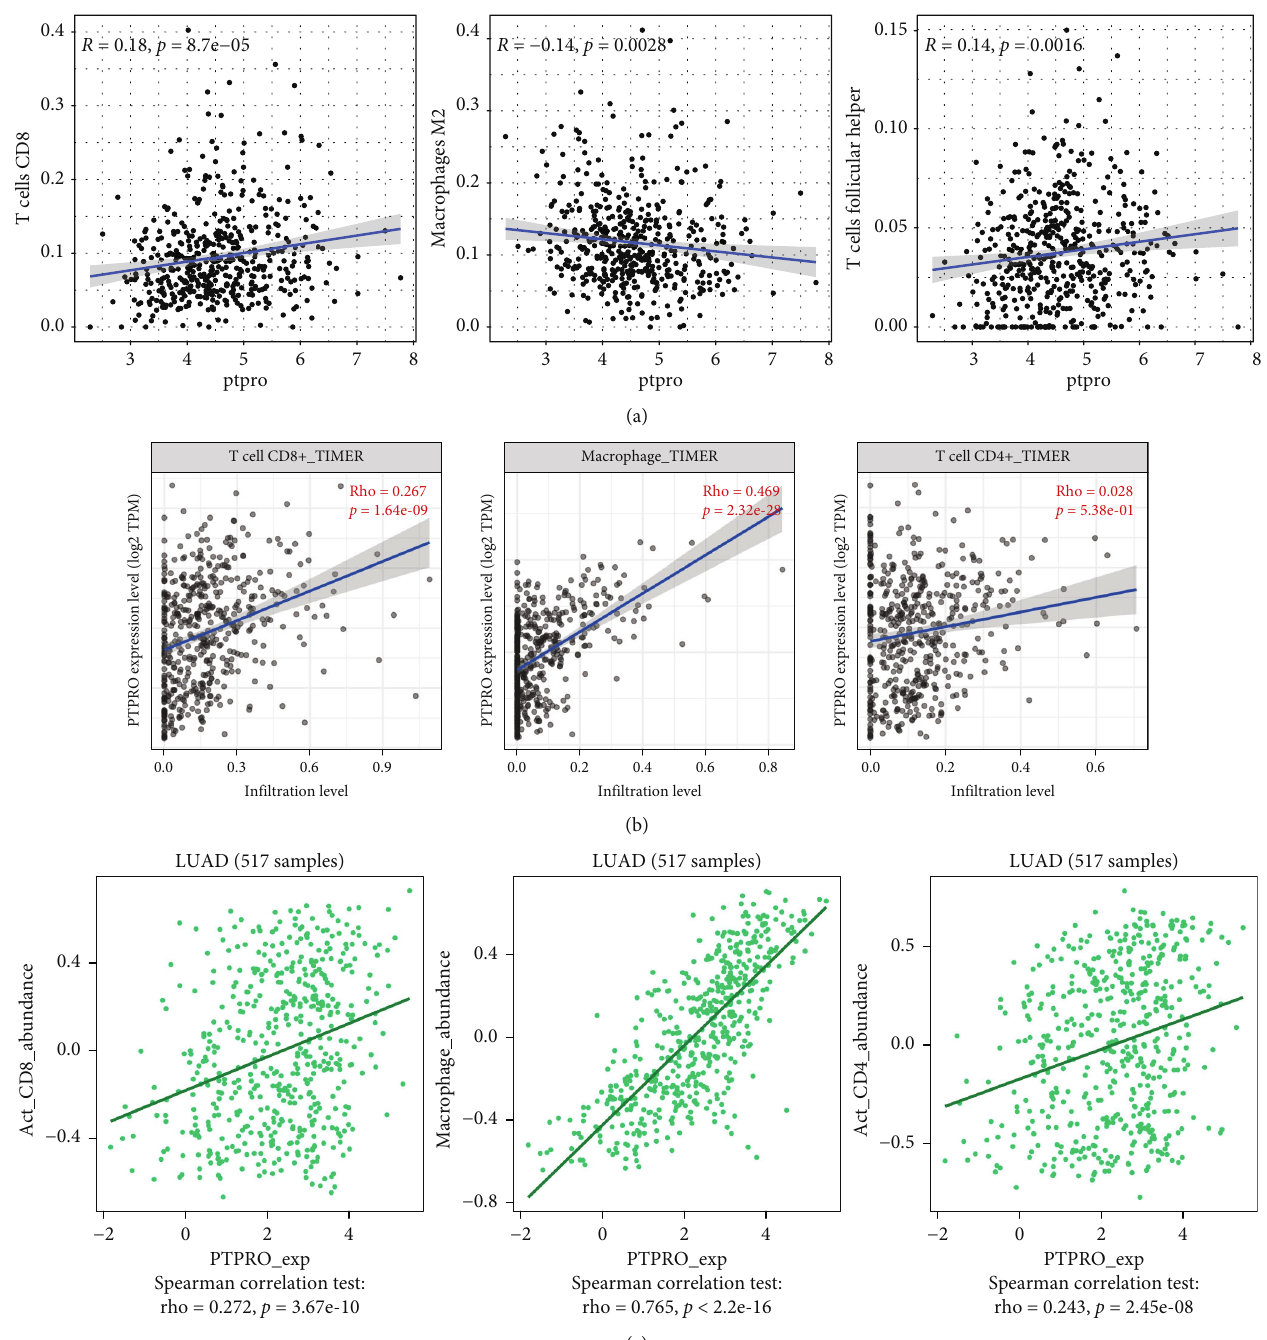
Figure 6: Correlation analysis of PTPRO expression level and immune cell in fi ltration. (a – c) TIMER, TISIDB, and CIBERSORT tools were used to analyze the correlation between the expression level of PTPRO and the in fi ltration of LUAD immune cells,